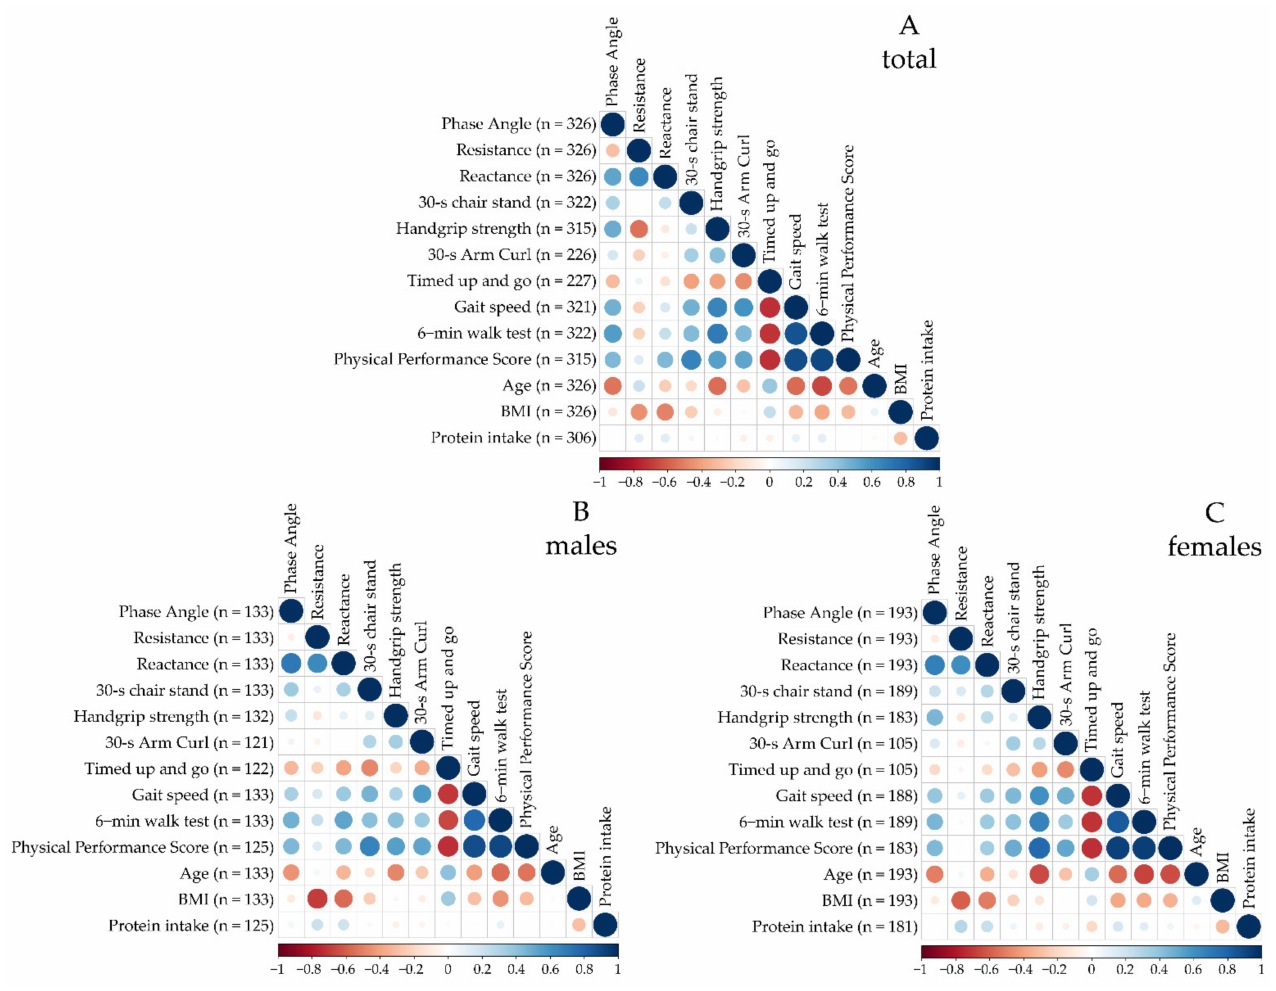
Figure 4. Correlation matrix for the total population ( A ), males ( B ) and females ( C ). The red and blue dots correspond to negative and positive correlations, respectively. Small dots with light colors represent lower intensity correlations, and larger dots with darker colors correspond to higher intensity